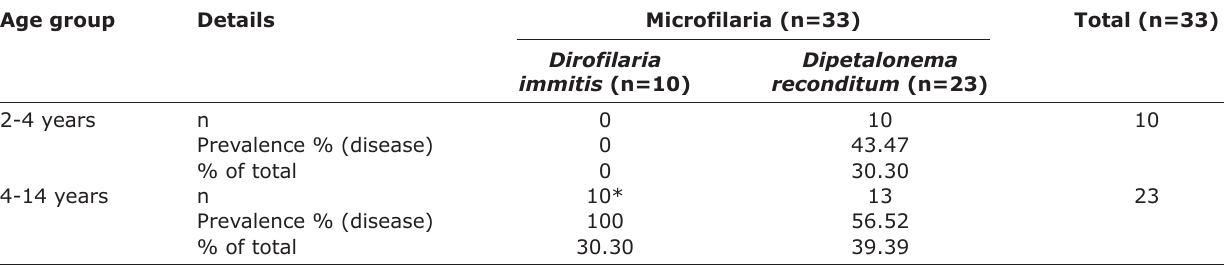
Table-3: Overall prevalence and distribution of microfilariae ( D. immitis and D. reconditum ) in different age groups of dogs from Gujarat state, India.